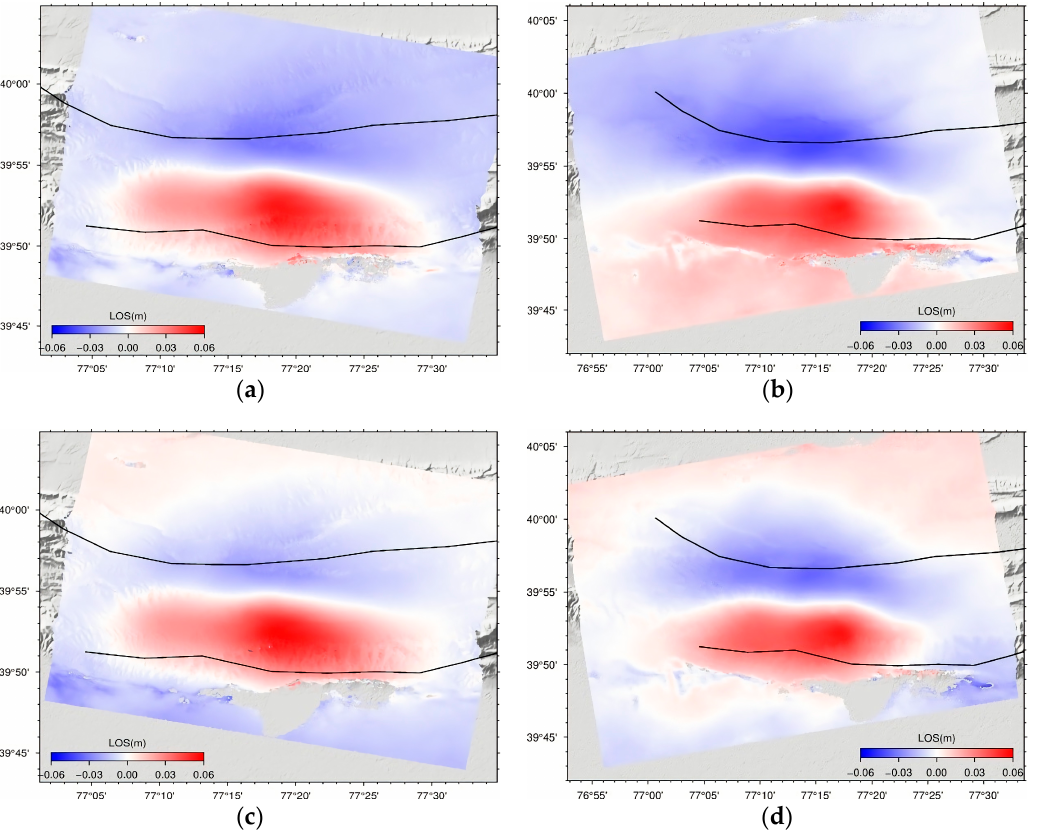
Figure 3. Deformation fields of the Jiashi Ms 6.4 earthquake acquired using Sentinel-1A data for descending and ascending tracks. ( a , b ) show the descending and ascending LOS coseismic deformation maps without tropospheric delay correction, respectively. ( c , d ) show the descending and ascending LOS coseismic deformation maps after atmospheric correction, respectively. The black lines denote the main faults. The positive values indicate that the earth’s surface moves toward the LOS direction.